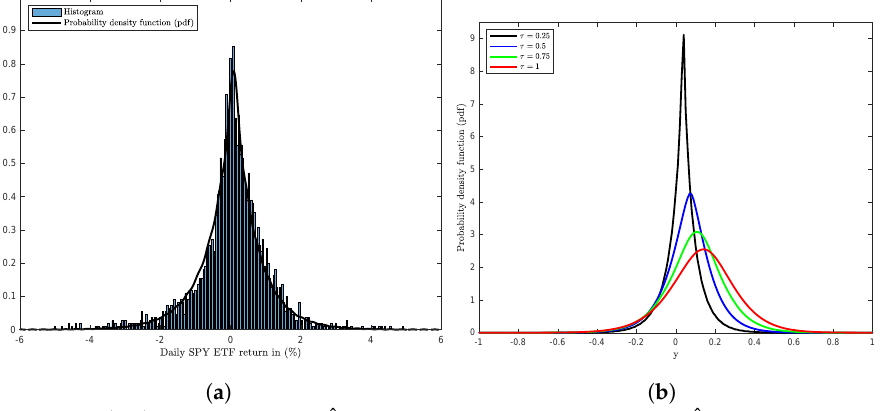
Figure 4. f ( y , t ) with ˆ µ = 0.0848, ˆ δ = − 0.0577, ˆ σ = 1.0295, ˆ α = 0.8845, ˆ θ = 0.9378: ( a ) daily SPY ETF return in (%) and ( b ) f ( y , τ ) : τ in